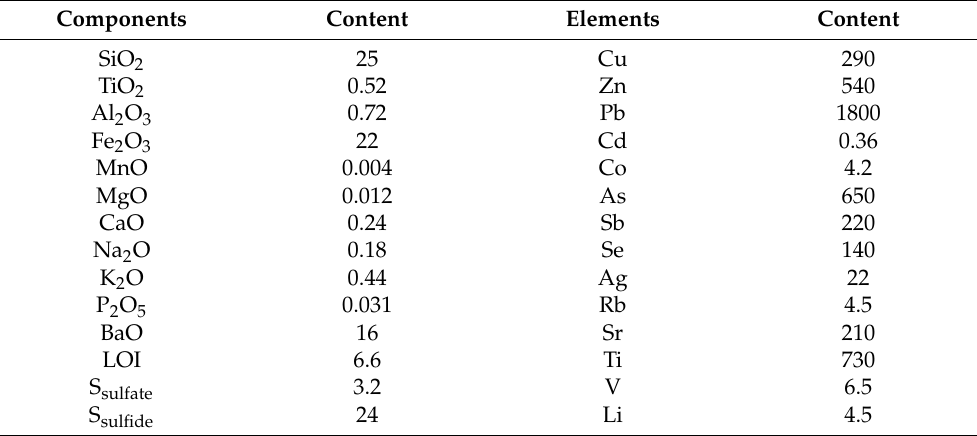
Table 2. Composition of the tailings sample for the experiment (SiO 2 –S sulfide in weight %, Cu–Li in mg · kg − 1